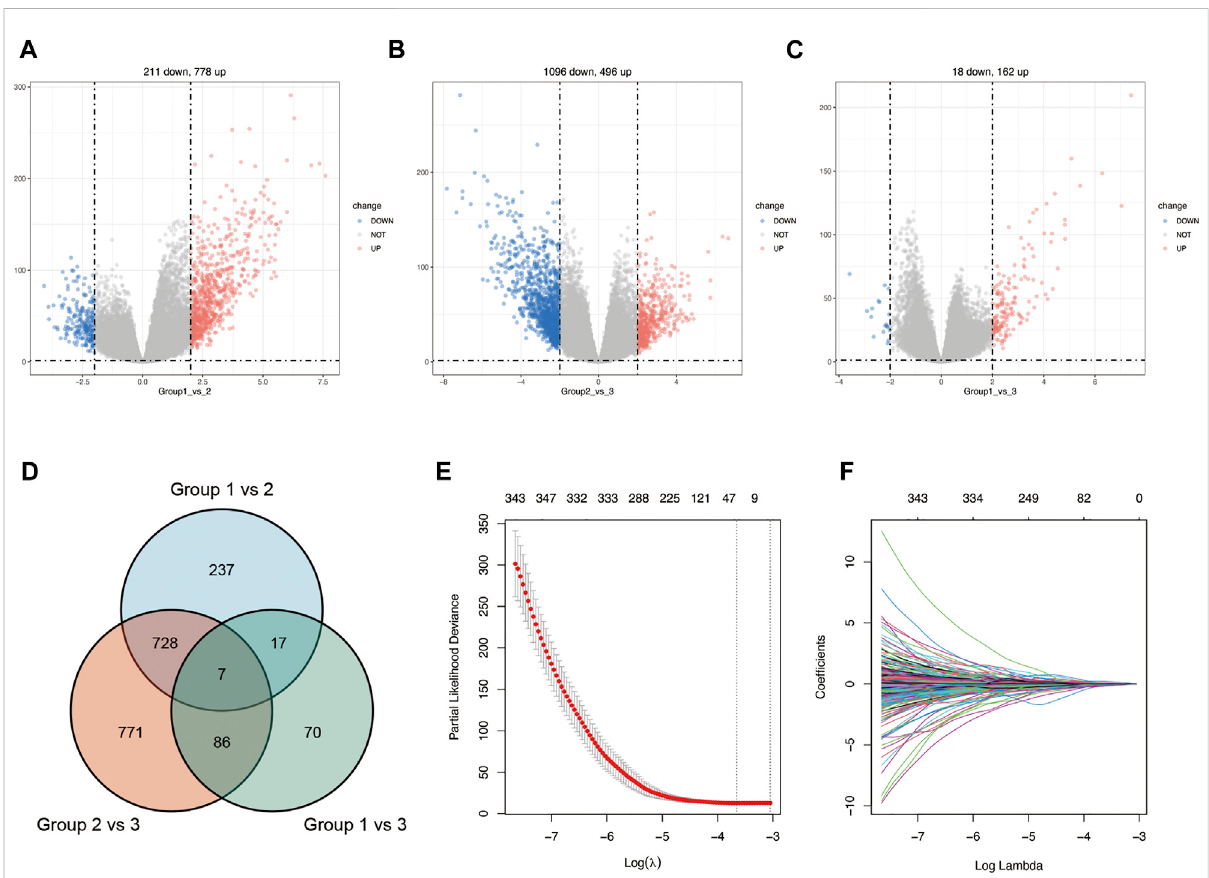
FIGURE 4 Construction of lasso regression model. Volcano plot of differentially expressed genes between cluster 1 vs. cluster 2 (A) , cluster 2 vs. cluster 3 (B) , and cluster 1 vs. cluster 3 (C) in BRCA. (D) . Venn diagram of differentially expressed genes between glycosylation-based groups. (E) . Cross- validation plot for the penalty term λ based on differentially expressed genes. Vertical bars represent acceptable maximum and minimum λ values with corresponding mean-squared error and the number of covariates. (F) Plots for lasso regression coef fi cients over different values of the penalty parameter λ